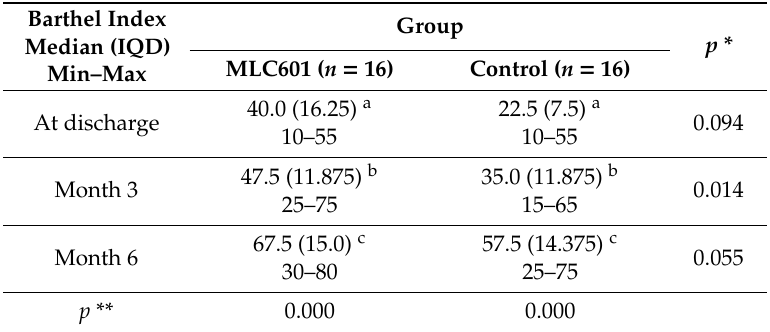
Table 3. Barthel Index (BI)